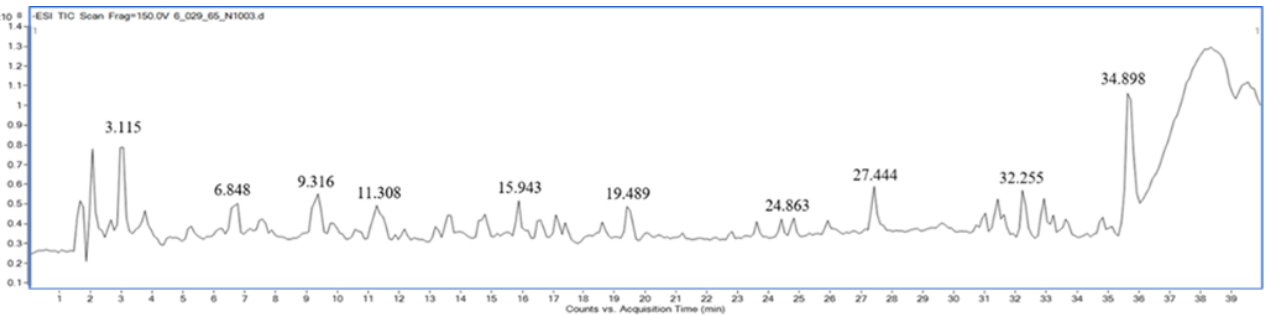
Figure 3. LC-MS chromatogram of ethanolic extract of Prabchompoothaweep remedy. Table 5. Effect of ethanolic extracts of M. fragrans , A. lancea , and Prabchompoothaweep remedy on parasite level and parasite suppression in the 4-day suppressive